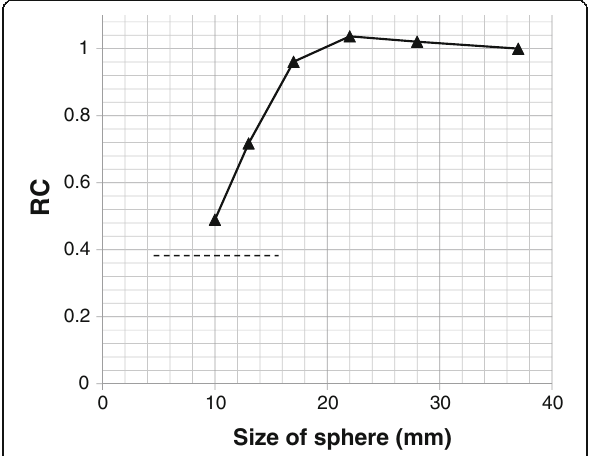
Fig. 9 The recovery coefficients (RC) measured for different sphere sizes. Images with 10-min acquisition were used. The dotted line indicates the value recommended in the Japanese guideline (>